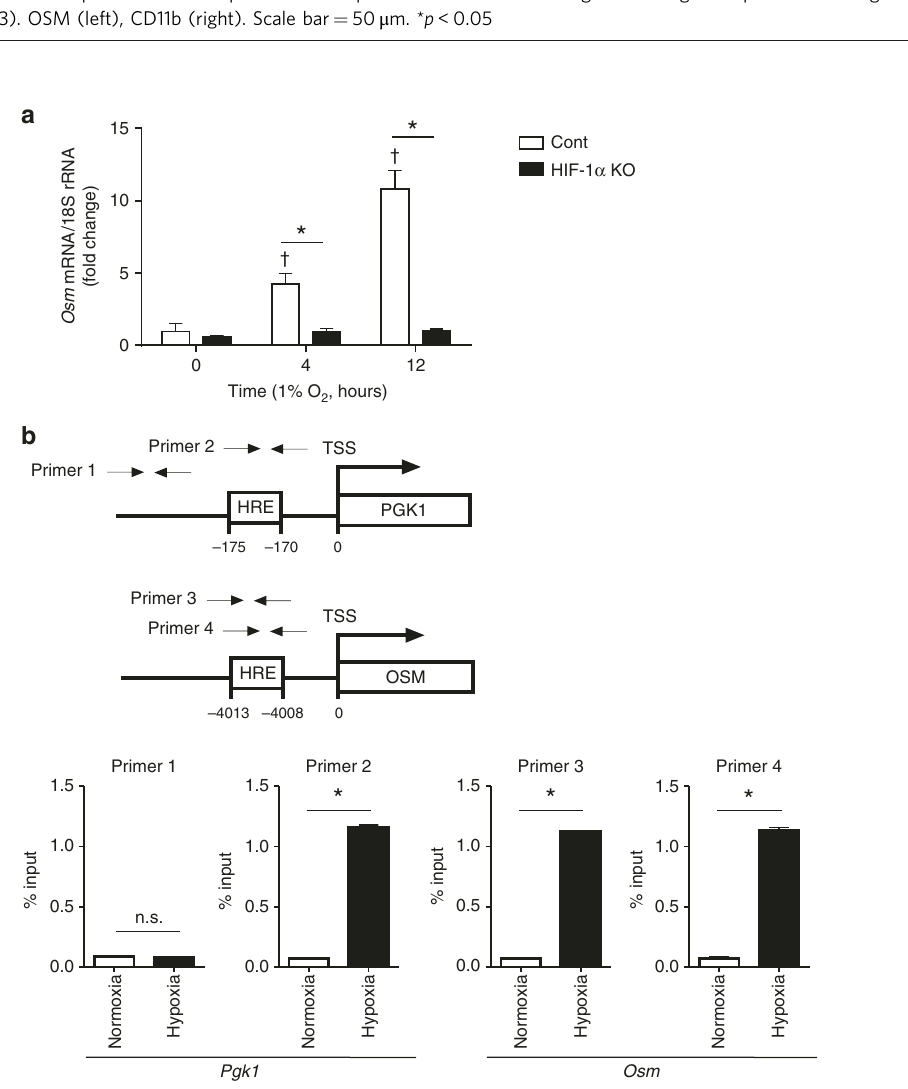
Fig. 4 OSM gene expression is induced in hypoxia through a HIF-1 α dependent manner. a Thioglycollate-elicited peritoneal macrophages (TEPMs) were isolated from hemtopoietic/endothelial-speci fi c HIF-1 α knockout mice (HIF-1 α KO) or cre negative littermates as a control (cont). The TEPMs were exposed to hypoxia (1% O 2 ), and the relative expression level of Osm mRNA was analyzed. The one-way ANOVA and Dunnett ’ s multiple comparisons test were used for the statistical analysis (F (2, 6) = 90.20). † p < 0.05 vs 0 h. The two-way ANOVA and Sidak ’ s multiple comparison test was performed for the statistical analysis (F (2, 12) = 94.66). * p < 0.05 vs cont. b HIF-1 α binding to the promoter of Osm gene was studied by chromatin immunoprecipitation coupled to detection by quantitative PCR. Primer set 1 and 2 were designed to detect the promoter legion ( − 500 and − 170 bp) of Pgk1 gene. Primer set 3 and 4 were designed to detect the hypoxia response element (HRE, − 4 kb) of Osm gene. Data show the mean and the standard deviation (effort bar) of technical triplicates from a representative experiment. Quantitative PCR analysis were repeated at least three independent experiments. Two-tailed t -test with Welch ’ s correction was used for the statistical analysis (Primer 1 (t = 1.527, df = 3.863), Primer 2 (t = 93.69, df = 2.011), Primer 3 (t = 197.7, df = 3.202), Primer 4 (t = 75.41, df = 2.505)). n.s. not statistically signi fi cant. * p <